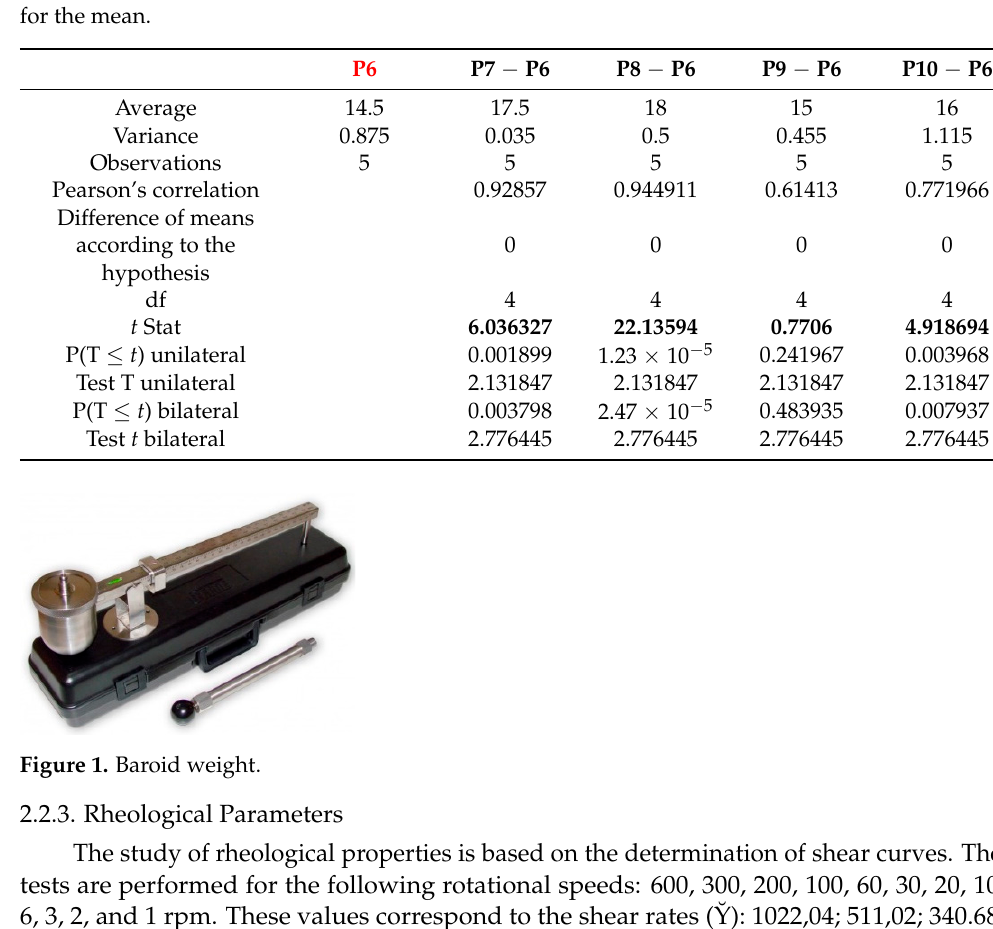
Table 5. Within-subject comparison (comparison of samples to baseline P6) t -test: pairwise pairing